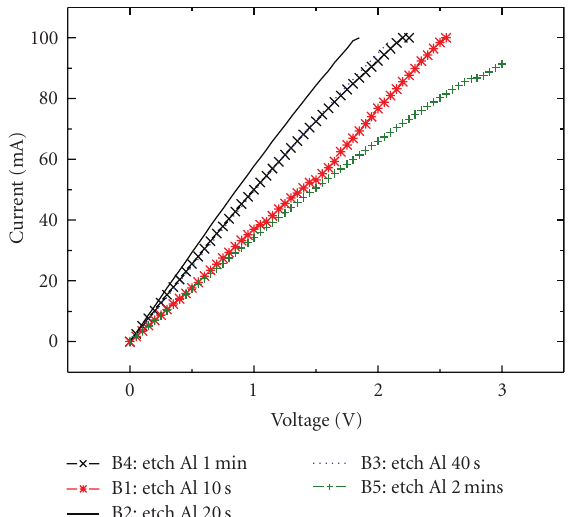
Figure 2: Optimised TLM processing summary for protected and passivated AlN/GaN MOS-HEMT samples. Processing includes (a) sample cleaning with only deionised water and deoxidation, (b) 2 nm Al deposition, (c) etching Al from Ohmic contact regions, (d) thermal oxidation of Al, (e) Ohmic metallisation, (f) Ohmic annealing, and (g) TLM measurements.